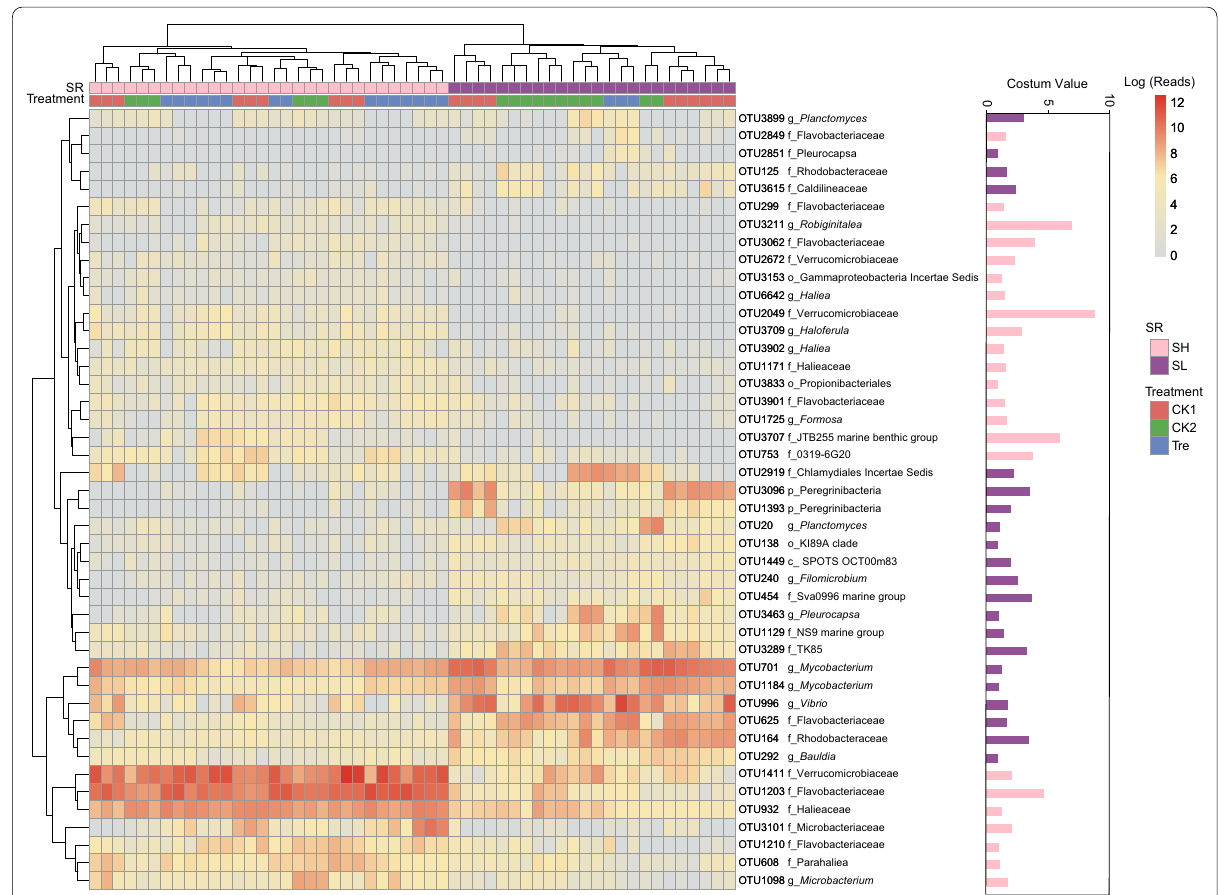
Fig. 3 Heatmap of differentially abundant OTUs for shrimp survival (SR) using ANCOM with custom value. The purple bar represents the OTUs were more prevalent in the gut of shrimp who survived less well, whereas the pink bar represents OTUs were more prevalent in the gut of shrimp who survived